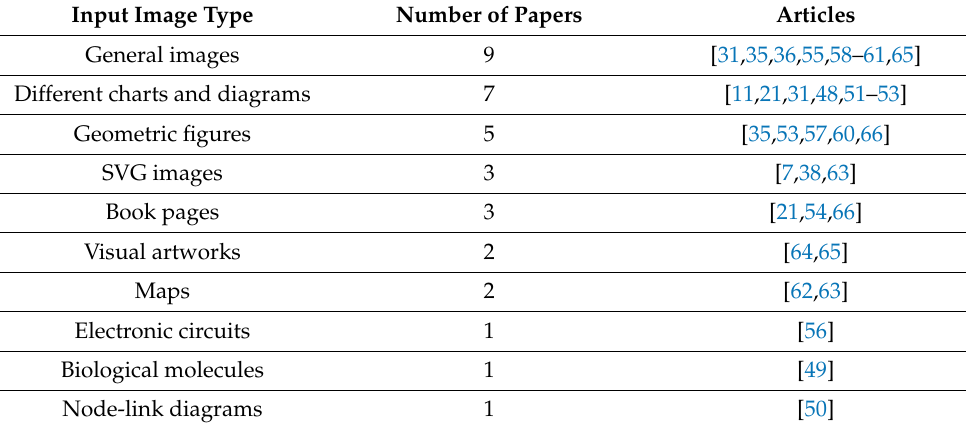
Table 4. Types of input images to generate tactile